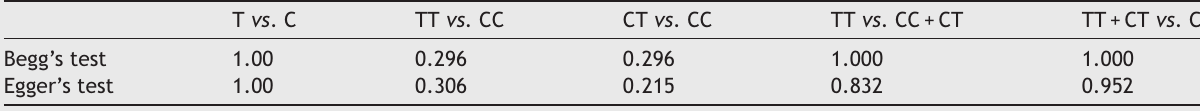
Egger’s test (Table 4) showed no publication bias for the